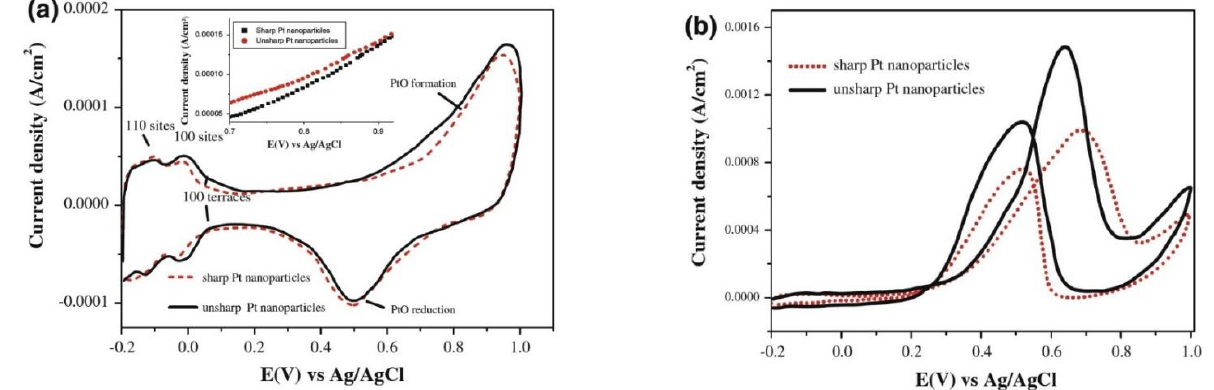
Figure 2. ( a ) Cyclic voltammogram of Pt nanoparticles in electrolyte solution of 0.1 M HClO 4 (scan rate: 50 mV/s, N 2 bubbling time: 30 min). ( b ) Cyclic voltammogram of Pt nanoparticles the solution of 0.1 M HClO 4 and 1 M CH 3 OH (scan rate: 50 mV/s, N 2 bubbling for 30 min prior to catalytic measurement [33]).